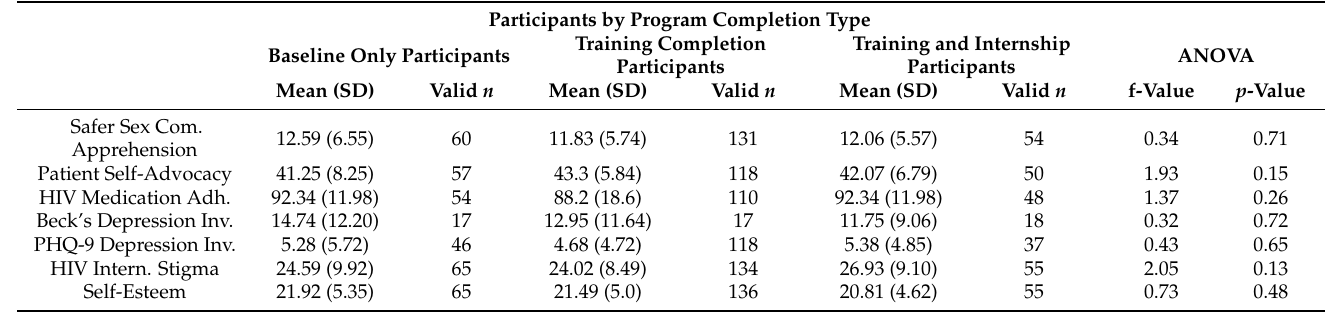
Table 4. Psychosocial inventories at baseline by level of program completion.